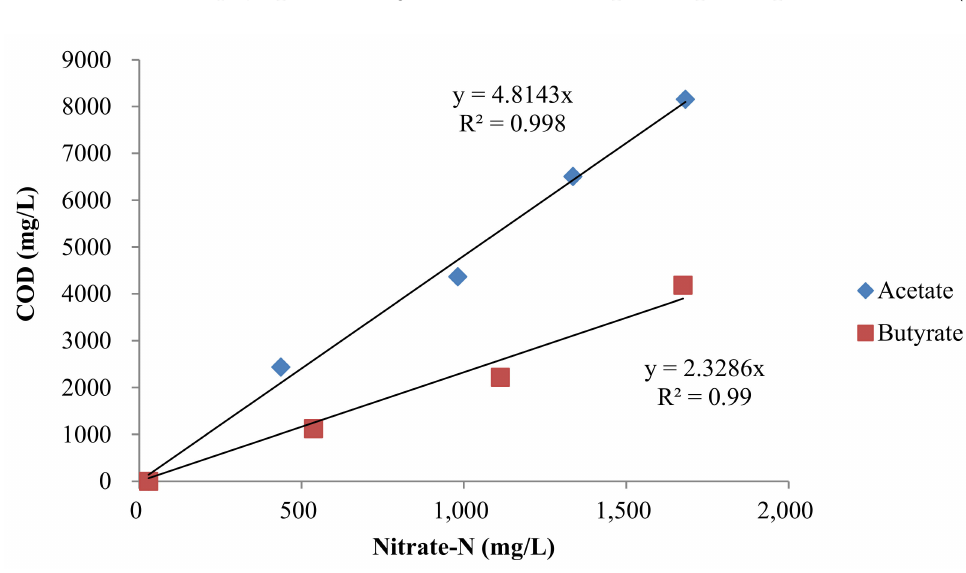
Figure 3. COD-based amounts of acetate and butyrate needed for nitrate-N